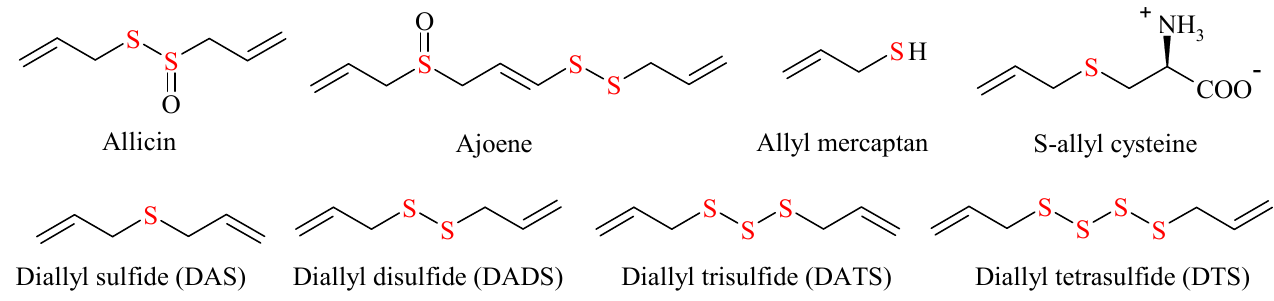
Figure 5. Leading organosulfur compounds of Allium